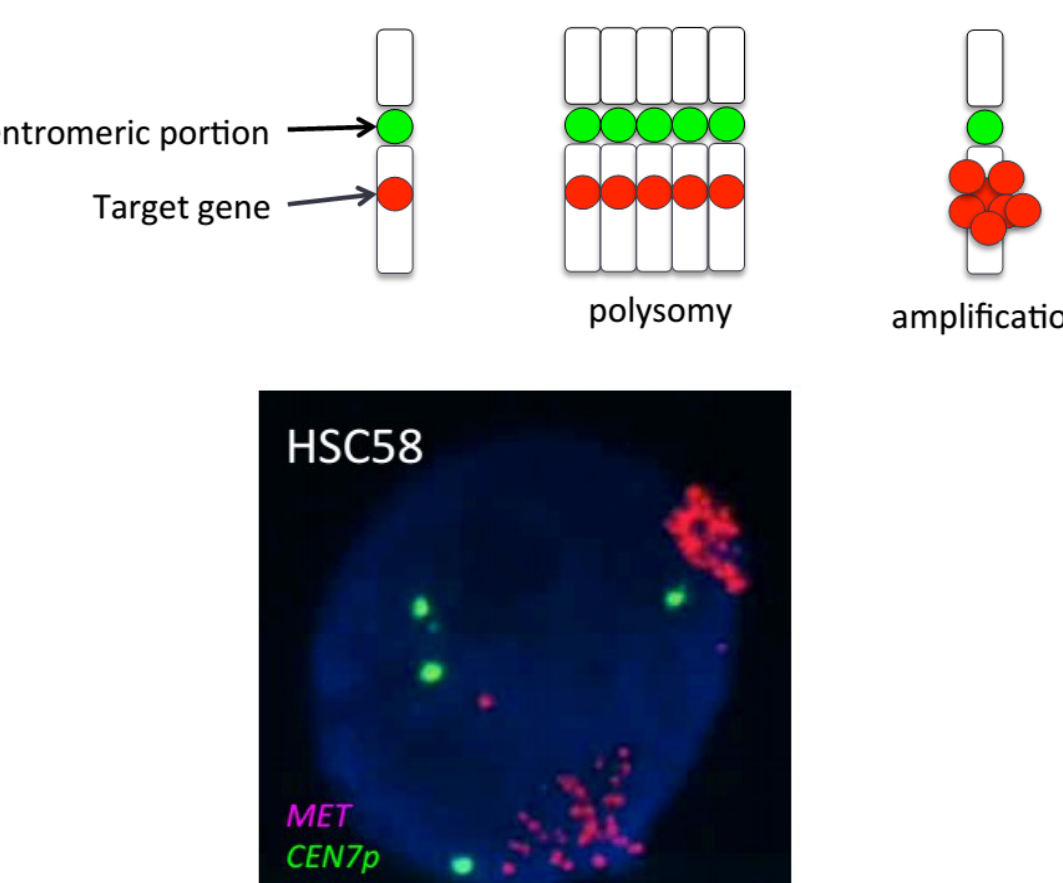
Figure 1. ( A ) Schematic comparison of gene amplification and polysomy. The ratio of the copy number for the target gene to that for the centromeric portion of the chromosome distinguishes an increased copy number of the target gene attributable to gene amplification from that resulting from extra copies of the chromosome (polysomy). ( B ) FISH analysis of a gastric cancer cell line (HSC58) positive for MET amplification. The image shows a single cancer cell, with green and red signals corresponding to CEP7 ( CEN7p ) and the MET locus,